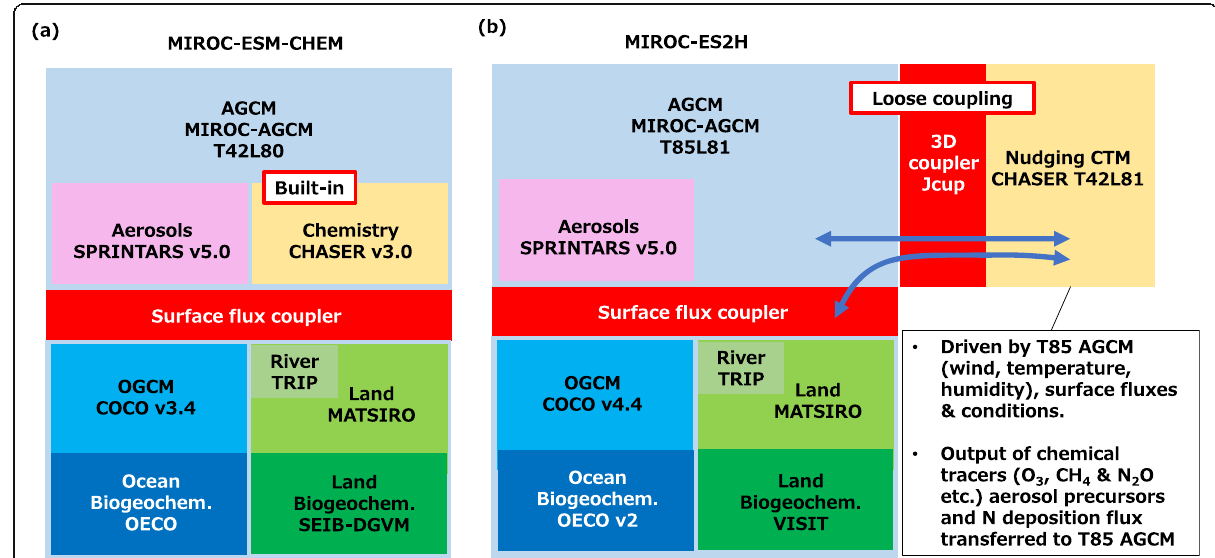
Fig. 3 Coupling of component models in a MIROC-ESM-CHEM used for CMIP5 and b MIROC-ES2H used for CMIP. T42 and T85 indicate horizontal resolutions that correspond to approximately 280 and 140 km, respectively. L80 and L81 indicate 80 and 81 vertical layers in the atmospheric